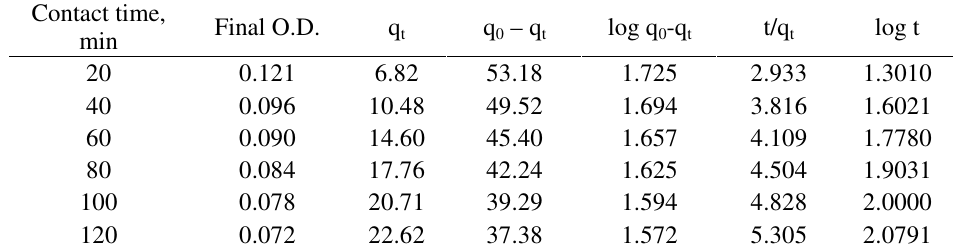
) = 60 ppm; O.D. for initial dye 0 ) = 0.011; q – q = 60.00-0.011 = 59.989) e 0 e